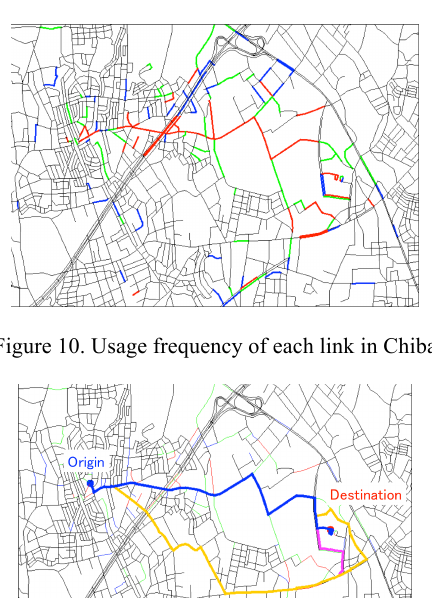
Figure 13. Usage frequency of each link in